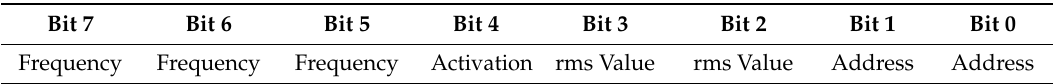
Table 1. Data frame for current source configuration.